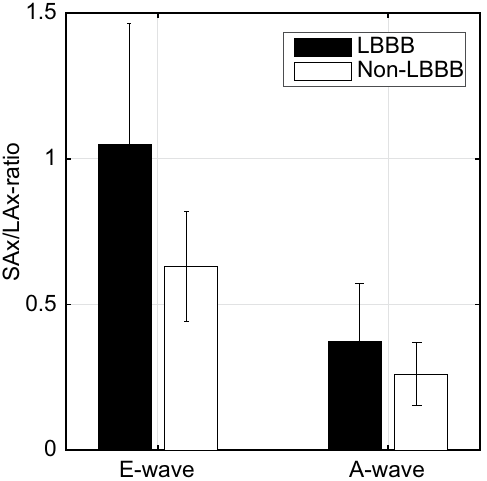
Figure 1. Mean ± std of the “SAx-max force/LAx-max force”-ratio during early diastolic filling (E-wave) and late diastolic filling (A-wave) respectively for the LBBB-patients (black bars) and non LBBB- patients (white bars). During E-wave the ratio was significantly larger for the LBBB patients compared to non-LBBB patients (P-value = 0.020), while there was no significant intergroup difference during A-wave (P-value =